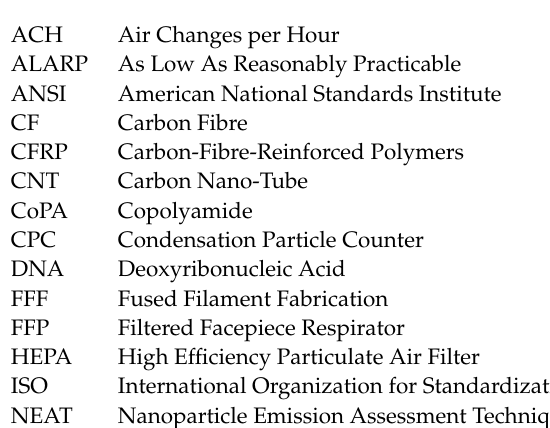
Figure S2: Illustration of the Instrument configuration for Case 1; Figure S3: Illustration of the Instrument configuration for Case 2; Figure S4: Instrument setup for Case 3; Figure S5: Measurement setup for Case 4a; Figure S6: Measurement setup for Case 4b; Figure S7: 3D printer modified toolhead; Figure S8: Plexiglass Enclosure extension; Figure S9: Particle size distribution for Case 4a; Figure S10: Particle size distribution for Case